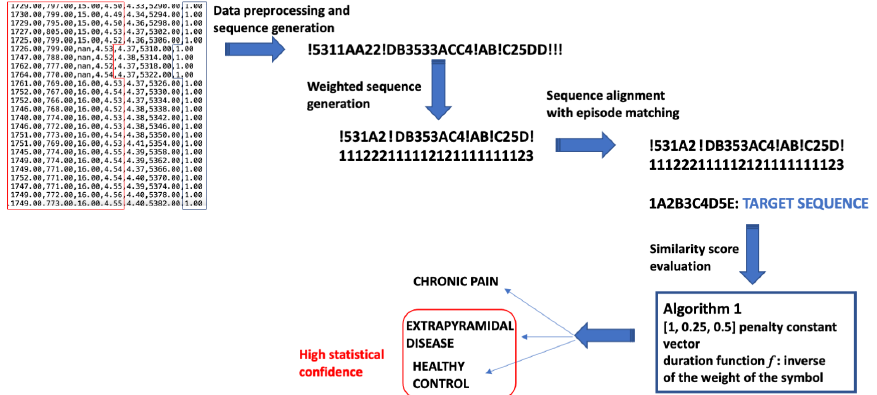
Figure 1. Processing pipeline: average gaze position per timestamp in fixation rows are processed to get the scan-path observed by the patient (the columns related to the pupils’ size are not taken into account); after creating the weight vector, we run the similarity score (with respect to the target sequence) to get the final patient score. Healthy patients and patients with extrapyramidal nervous system disease are distinguished with high statistical